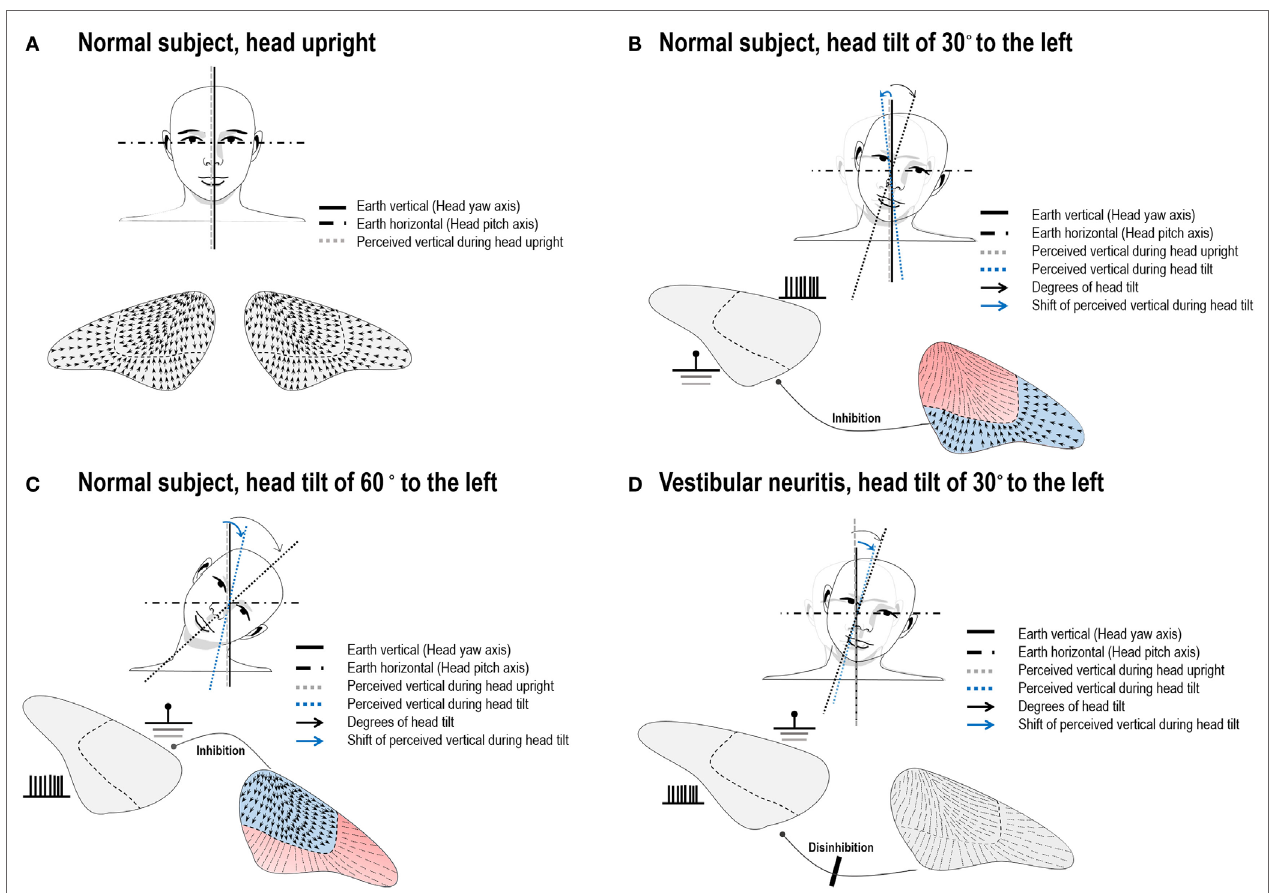
FigUre 2 | Illustration of arrangement of the utricular hair cells and hypothetic neuronal activities during head tilts in normal subjects and in a patient with left vestibular neuritis (VN). (a) The hair cells of an opposite polarization are oriented toward the striola of the utricular macula. In normal subjects with the head upright, the subjective visual vertical (SVV) is aligned with the gravitational vertical and the yaw axes of the eyes and head. (B) Head tilts of small angles would activate the lateral portion of the utricle on the tilted head side. This would result in overall deflections of the hair cells in the opposite direction of a head roll tilt, and hence lead to a small contraversive shift of the SVV (E-effect). (c) We hypothesize that larger head tilts would more strongly activate the medial portion of the utricle on the head tilted side, while the neuronal activities on the lateral portion in the ear on the side of head tilt and on the medial portion in the other ear are inhibited. This would result in the net neuronal activities directing toward the side of a head tilt, resulting in a shift of the SVV in the direction of head tilt (A-effect). (D) If a patient with left VN slightly tilts his/her head to the ipsilesional side, afferent signals from the lateral portion of the utricle cannot be generated in the left ear and commissural inhibition of the activities from the corresponding portion of the utricle in the right ear does not occur. Thus, the disinhibited neuronal activities from the intact ear would deviate the SVV in the direction of head tilt, resulting in A-effect. Blue colored portions indicate activation of the hair cells while red colored portions represent inhibited neuronal